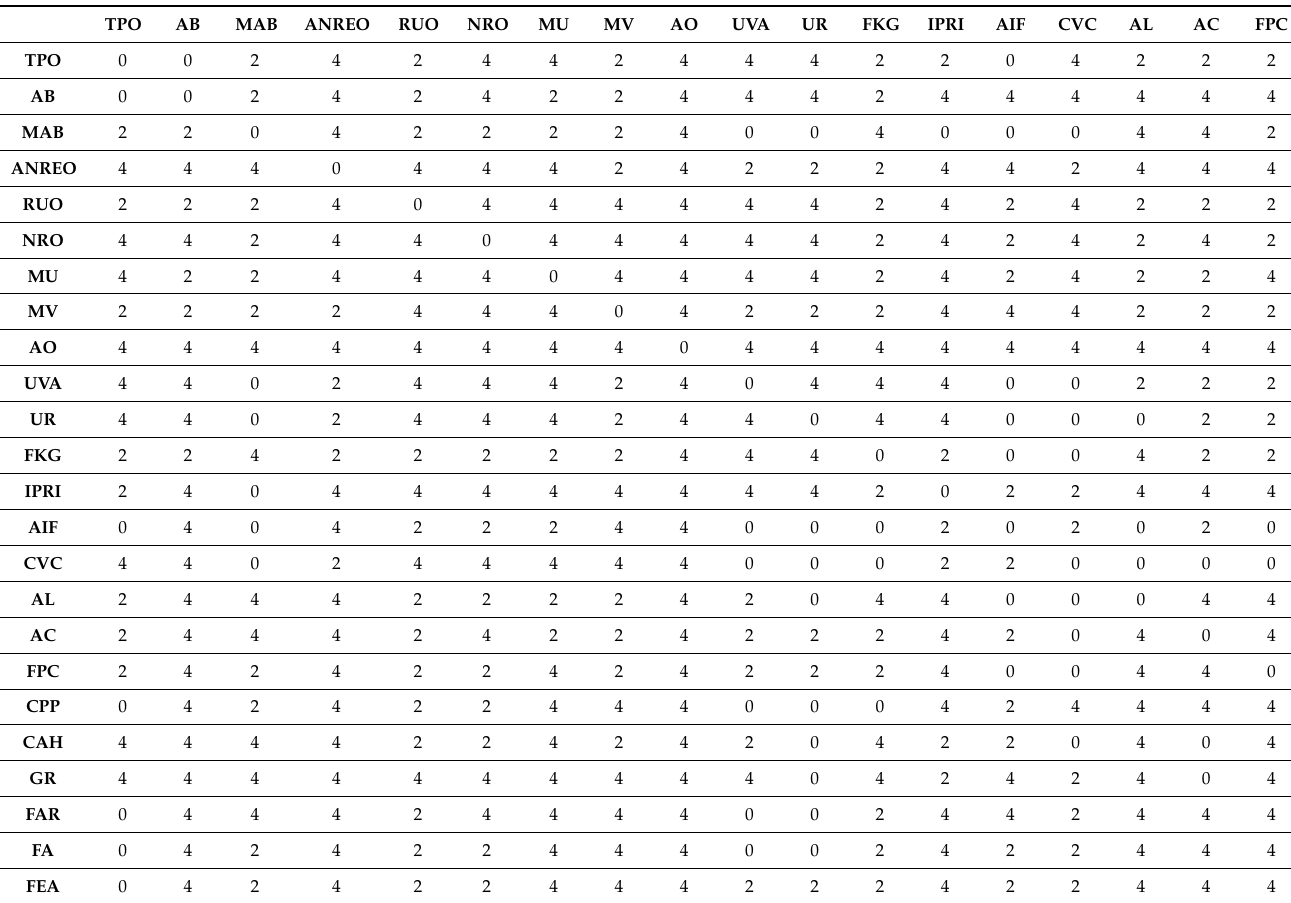
Table A3. First part of the matrix table of the quantification of relationships among actants involved in the